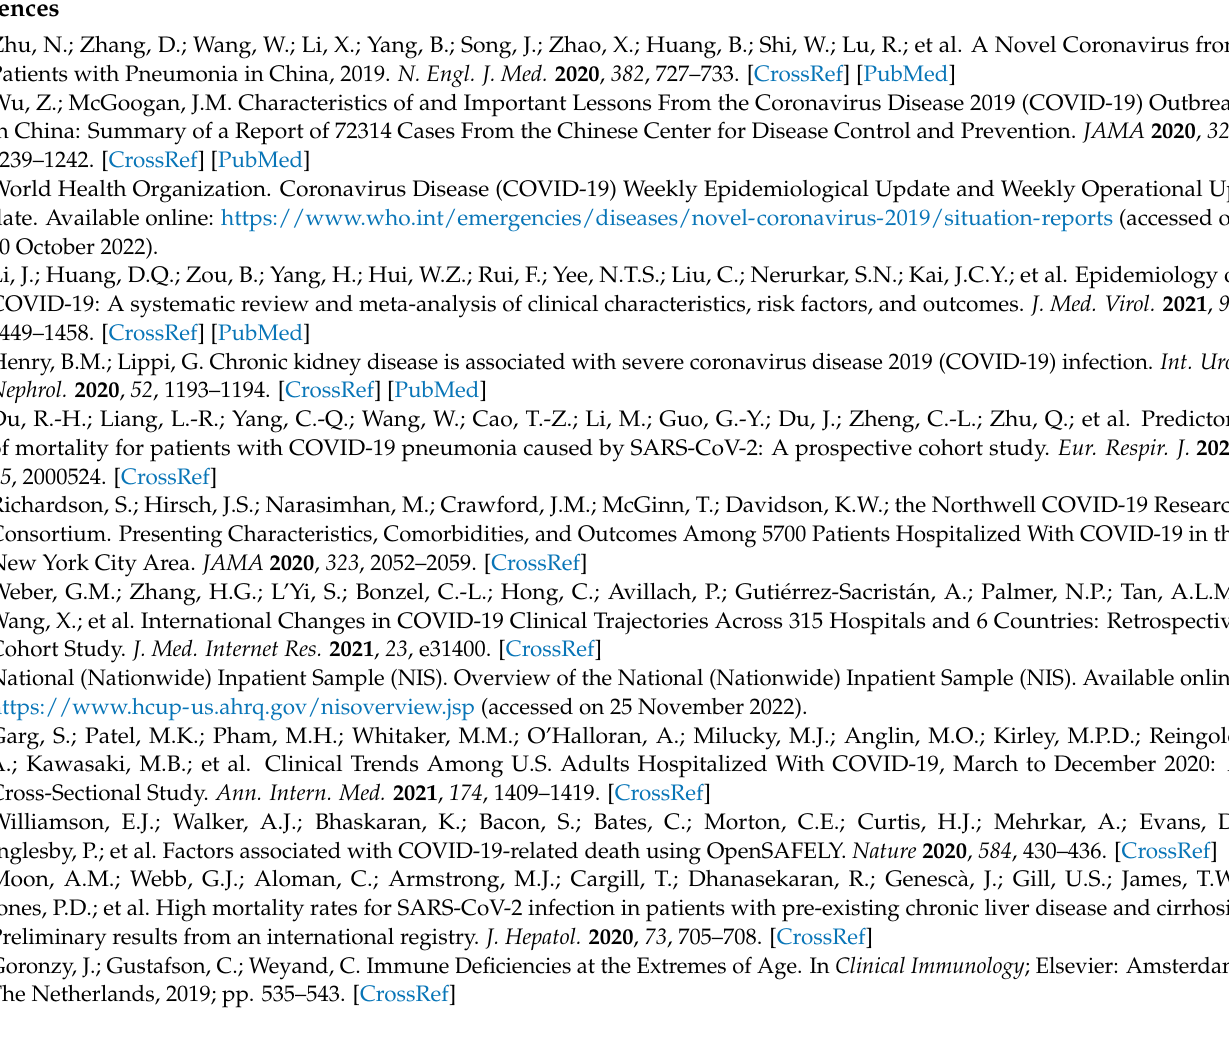
Table S2: ICD-10 codes of